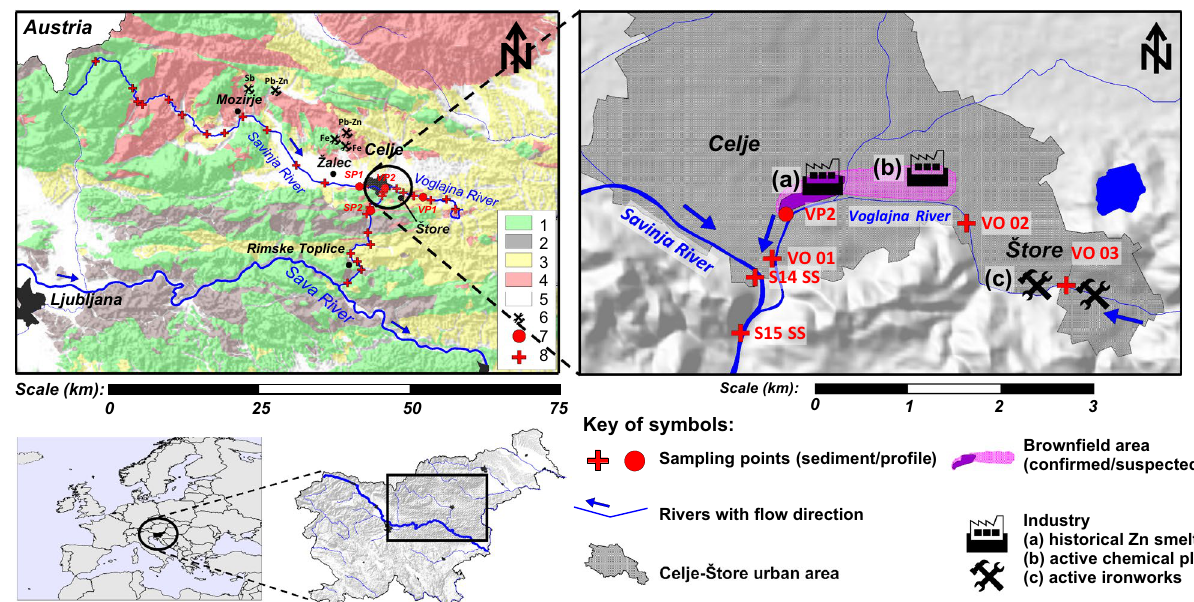
Figure 1. Map of the investigated area, its geological and morphological settings, location of samples and main potential anthropogenic sources of elements. 1—mainly Mesozoic carbonates (limestone, dolomite); 2— Paleozoic clastites; 3—Paleogene and Neogene sedimentary clastic rocks; 4—vulcanites and felsic igneous rocks of various ages; 5—Paleocene–Pleistocene alluvial sediments in basins; 6—small-scale metal mineralisation in the catchment area; 7—alluvial sediment sampling location (profiles), 8—stream sediments sampling locations. The maps were generated using Golden Software Surfer, ver. 21.1.158, https:// www. golde nsoft ware. com/ produ cts/ surfer.